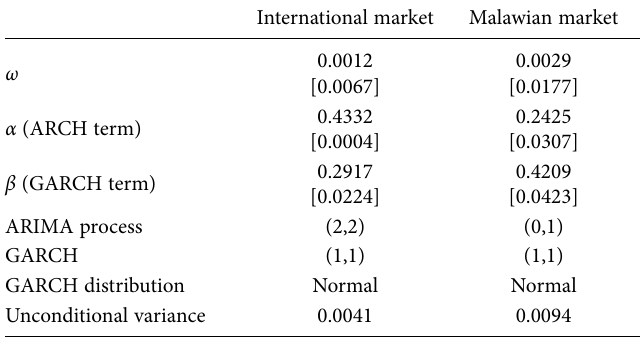
Table 3. GARCH estimate of maize price volatility for the international and Malawian markets (January 1991-March